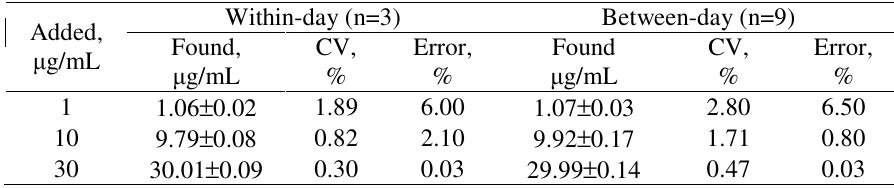
Table 2. Accuracy and precision data of determination of copper (1-30 µ g/mL) in the presence of nickel (10 µ g/mL) by third- derivative spectrophotometry.